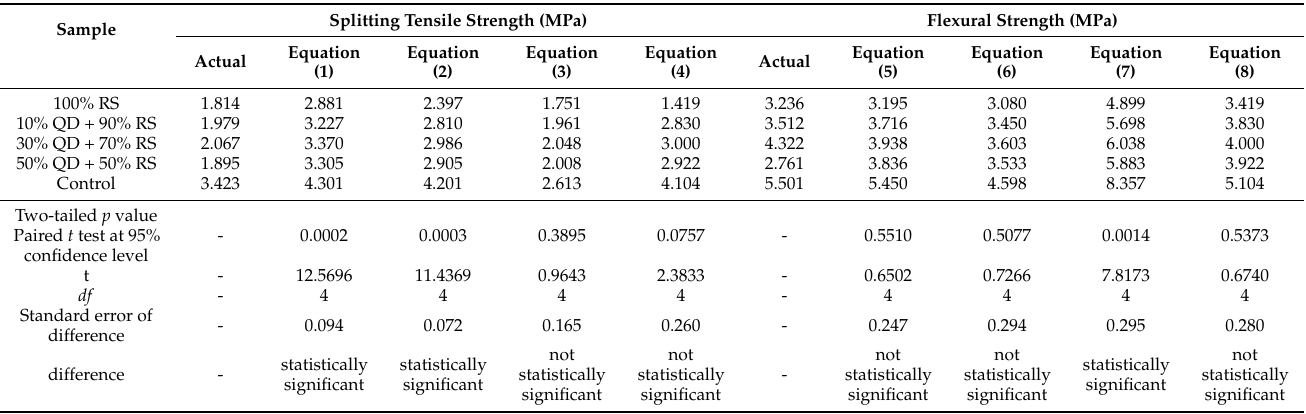
Table 7. Splitting tensile strength and flexural strength for concrete specimens with different cur- ing periods.